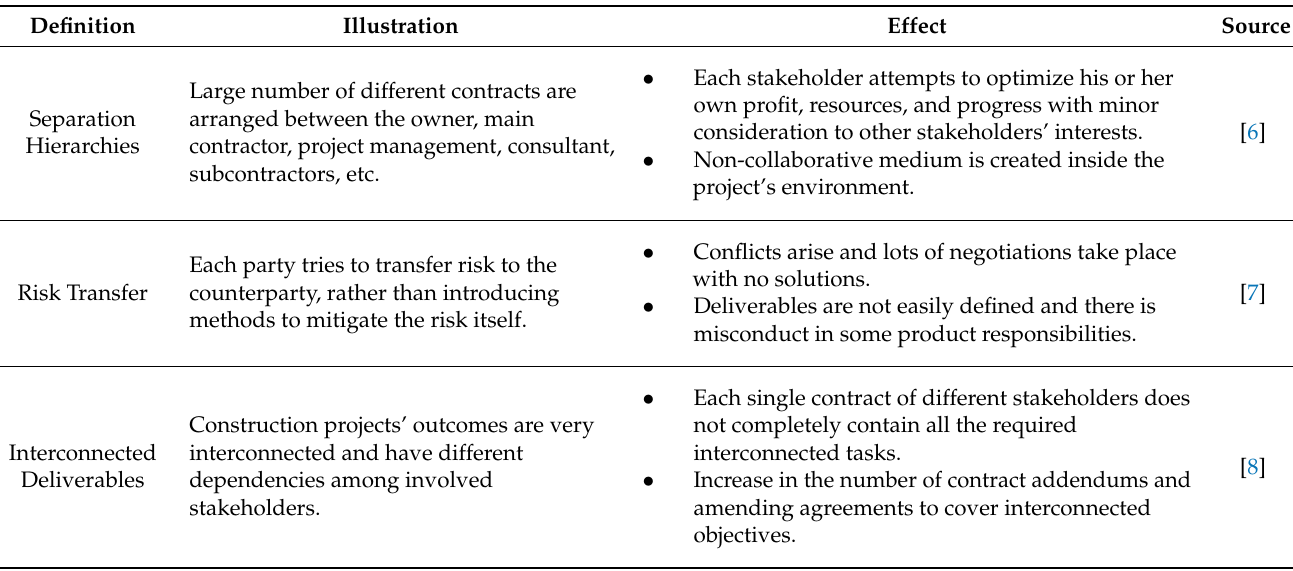
Table 1. Examples of traditional project delivery systems’